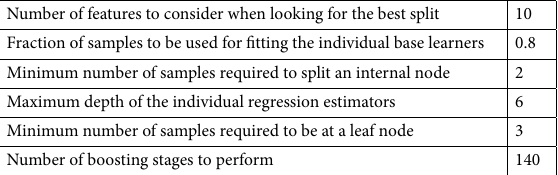
Table 1. The parameters used in Gradient Boosting trees.